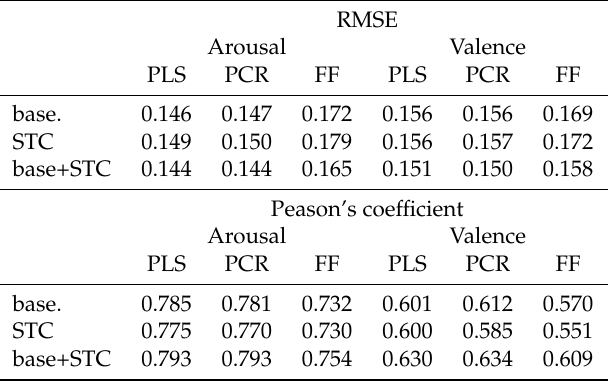
RMSE Arousal Valence PCR